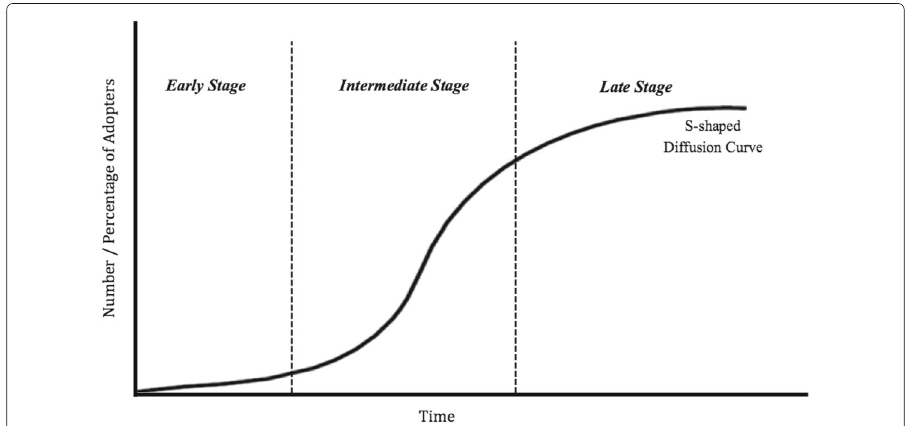
Fig. 1 Peer effects at different stages of the diffusion